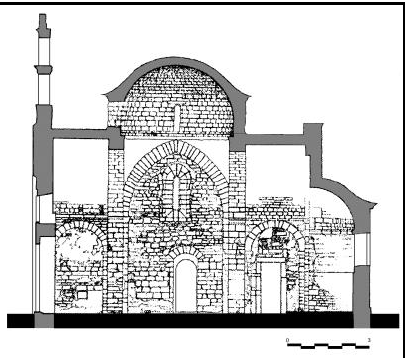
Figure 5. Cross-section of the Church of St. Luke.